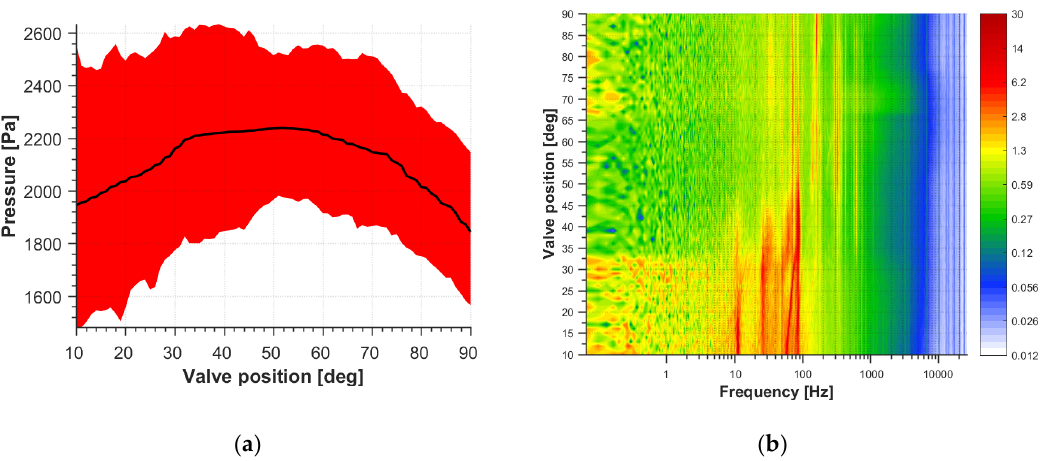
Figure 4. Pressure variation depending on the valve position measured in the diffuser at impeller rotational speed 70 Hz. ( a ) The left plot represents the min-to-max plot ( red ) and the pressure average value ( black ). ( b ) The right plot represents the spectral map with the colormap in the logarithmic scale.